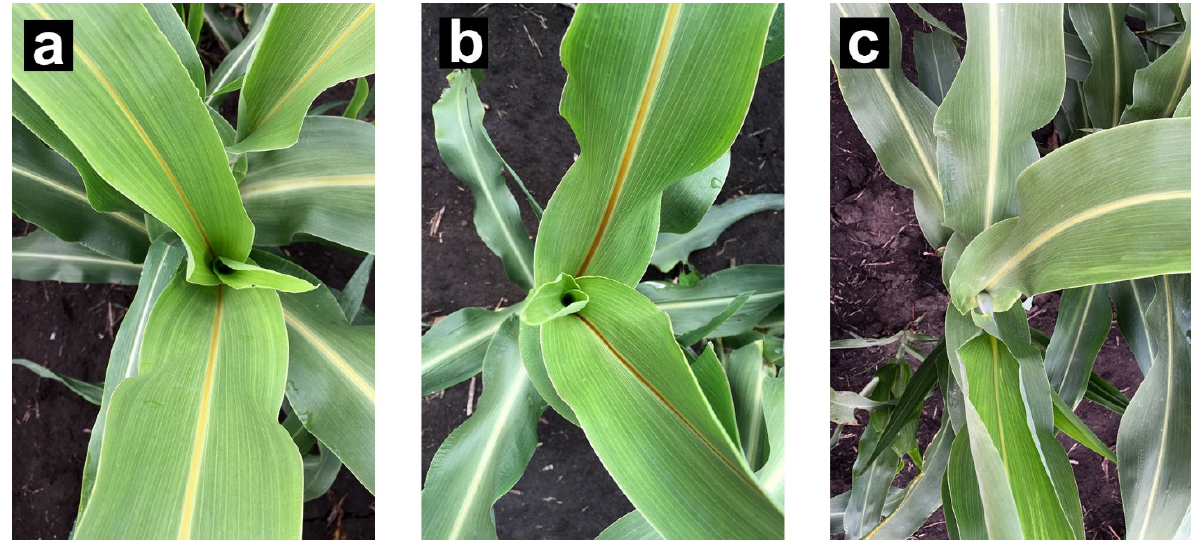
Figure 5. Visible midrib phenotypes of bmr19 mutants and wildtype in the BTx623 background. Photos taken from field grown plants at early boot stage: ( a ) brown midrib line (BTx623ms3 × bmr19)BC 2 F 4 , carrying the bmr19-ref allele; ( b ) brown midrib BTx623 EMS line 2354, carrying the bmr19-2 allele; ( c ) normal midrib BTx623, carrying the wildtype ( Bmr19 ) allele.